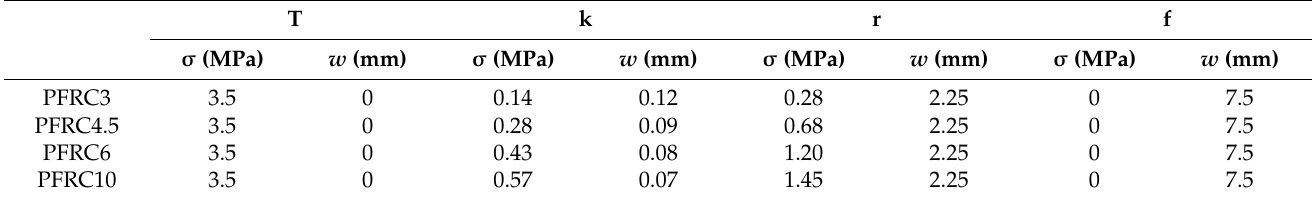
Table 2. Coordinates of the points that define the trilinear model for each fibre dosage according to the point nomenclature provided in Figure